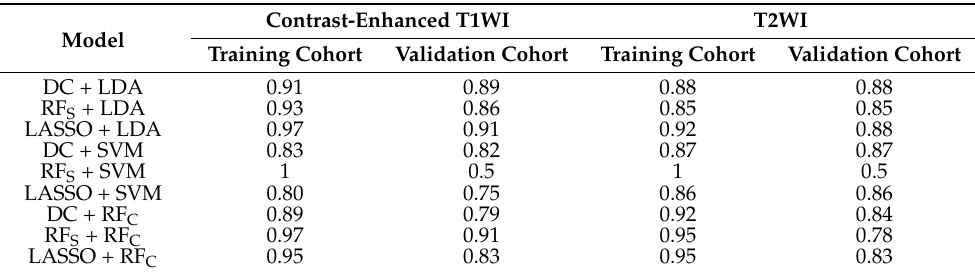
Table 2. AUCs of the training and validation cohorts in different models using parameters from the contrast-enhanced T1WI or T2WI. Contrast-Enhanced T1WI T2WI Model Training Cohort Validation Cohort Training Cohort Validation Cohort DC + LDA 0.91 0.89